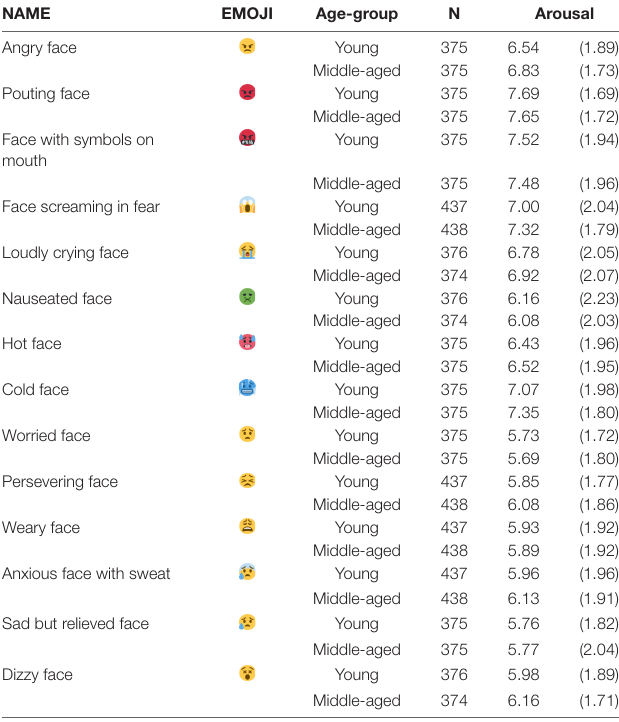
TABLE 1 | Negative emojis show differences in arousal levels by age group per cluster for strongly negative and moderately negative sentiments.